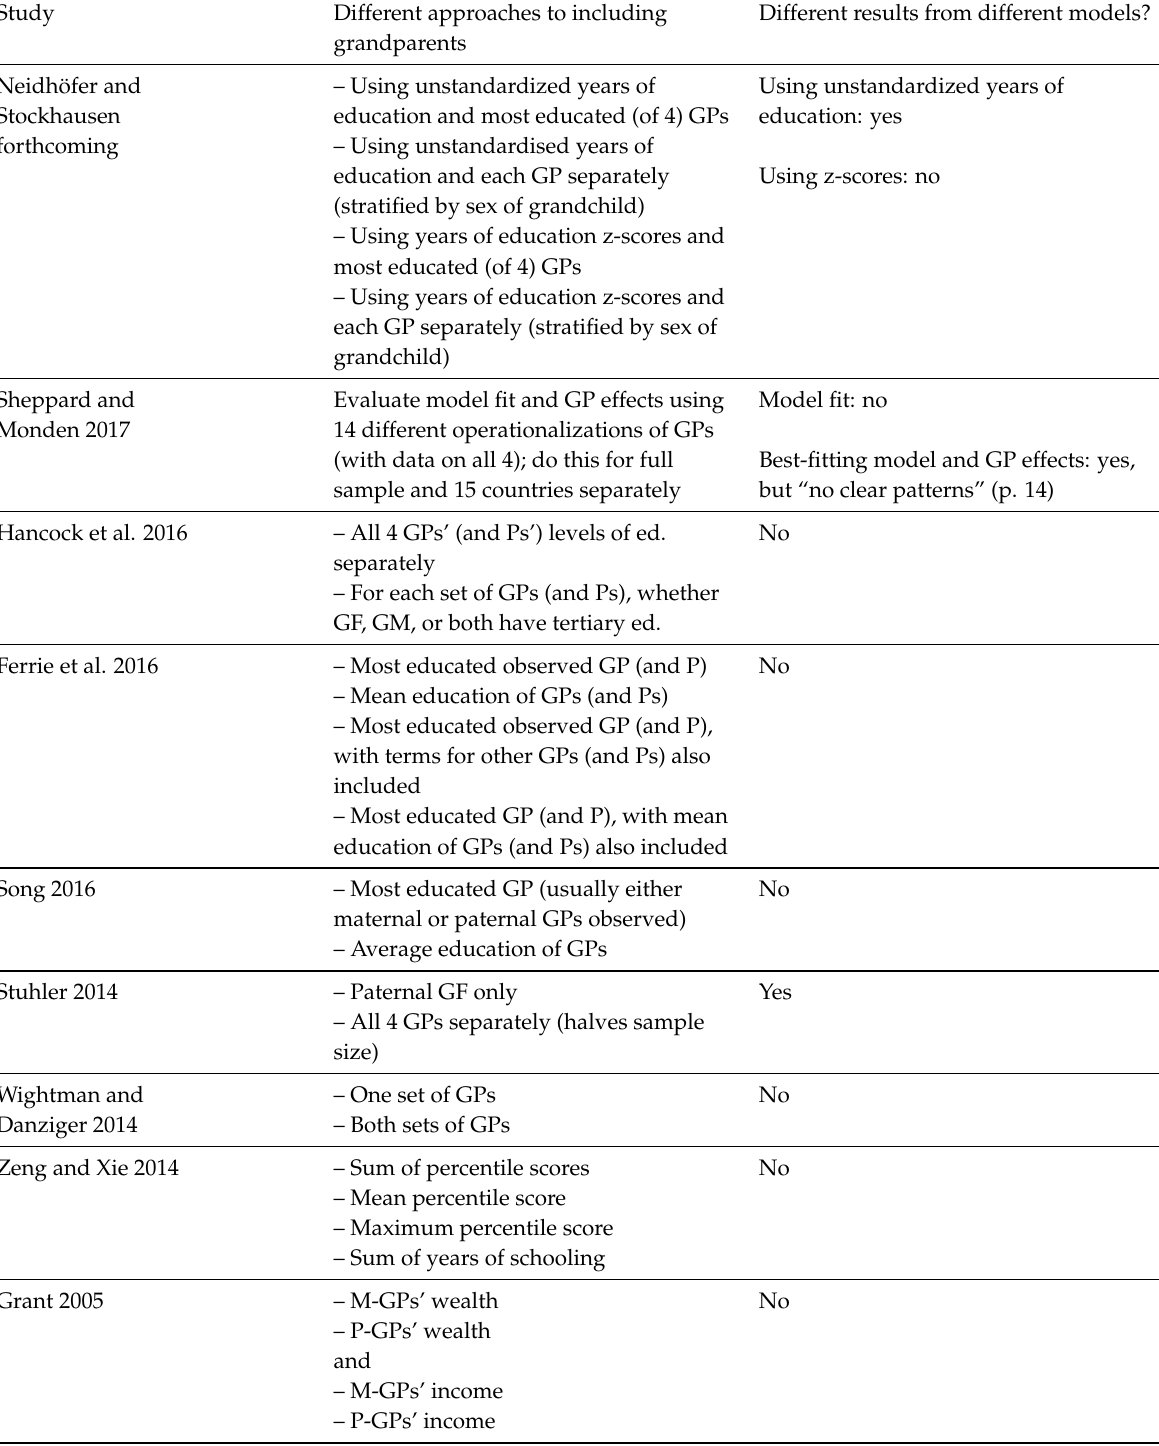
Table 4: Robustness of findings to different operationalizations of grandparental